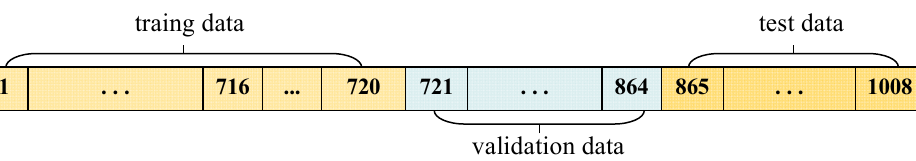
Figure 8. Distribution of training validation and test data.